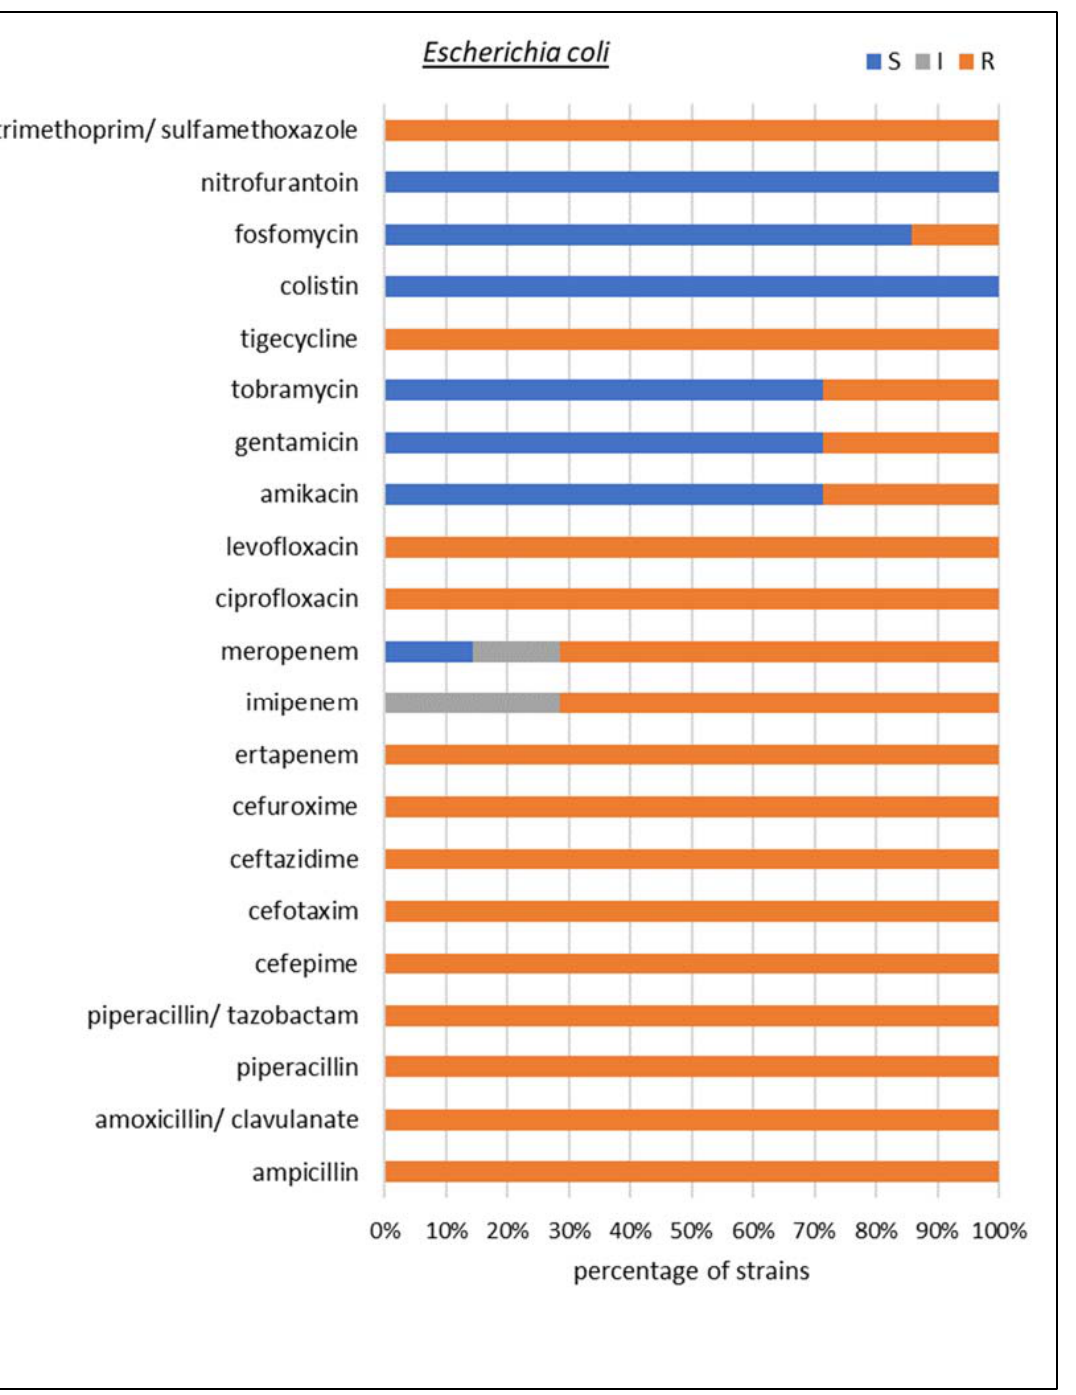
Figure 6. Drug susceptibility of the studied Escherichia coli strains producing carbapenemases ( n = 7).